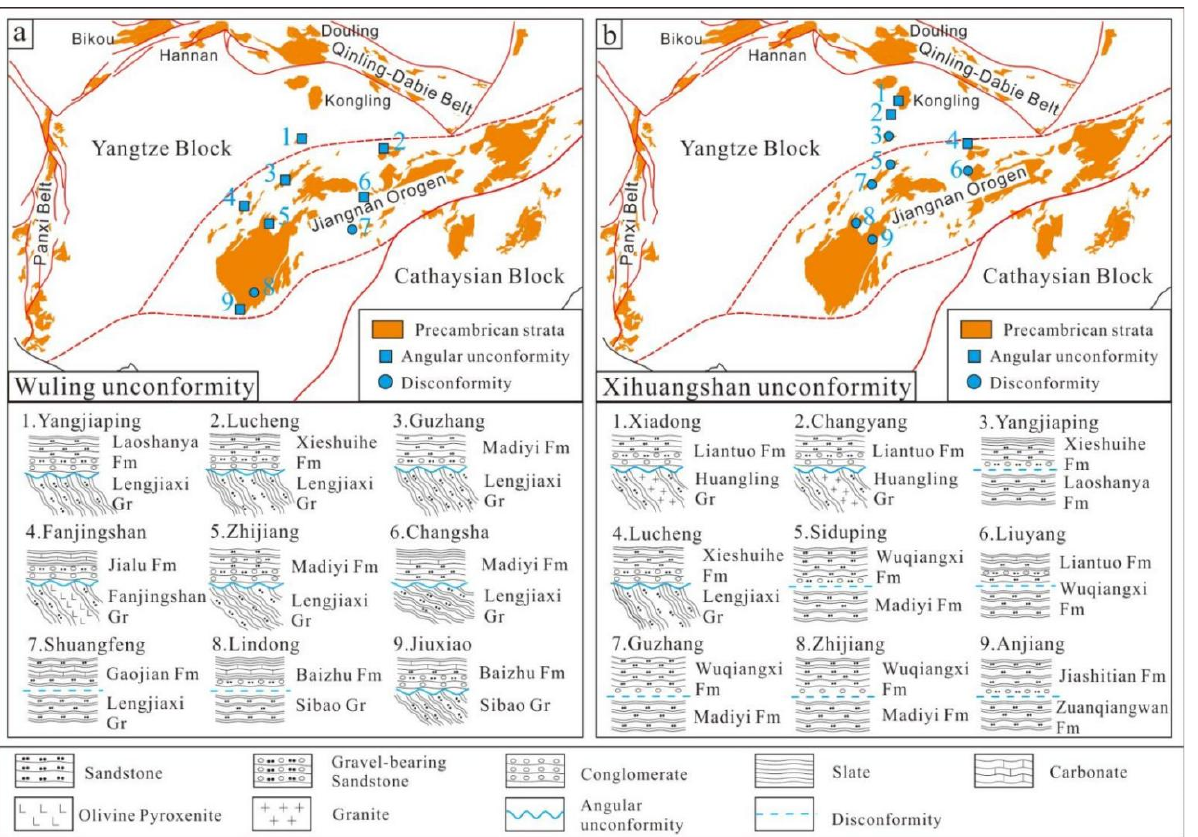
Figure 8. ( a ) Plane distribution map of Wuling unconformity (modified after [42,77]); ( b ) Plane distribution map of Xihuangshan unconformity (modified after [16,42,55,77–83]).